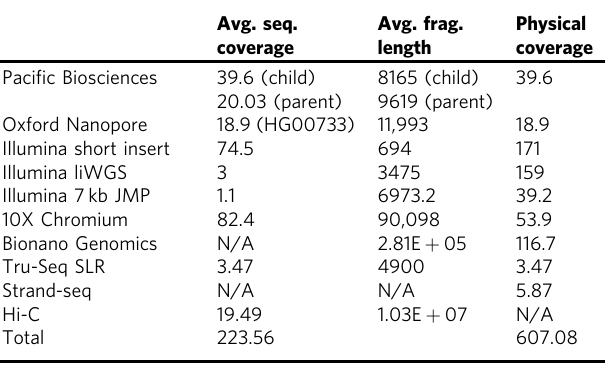
Table 1 Summary of sequencing statistics Avg. seq.